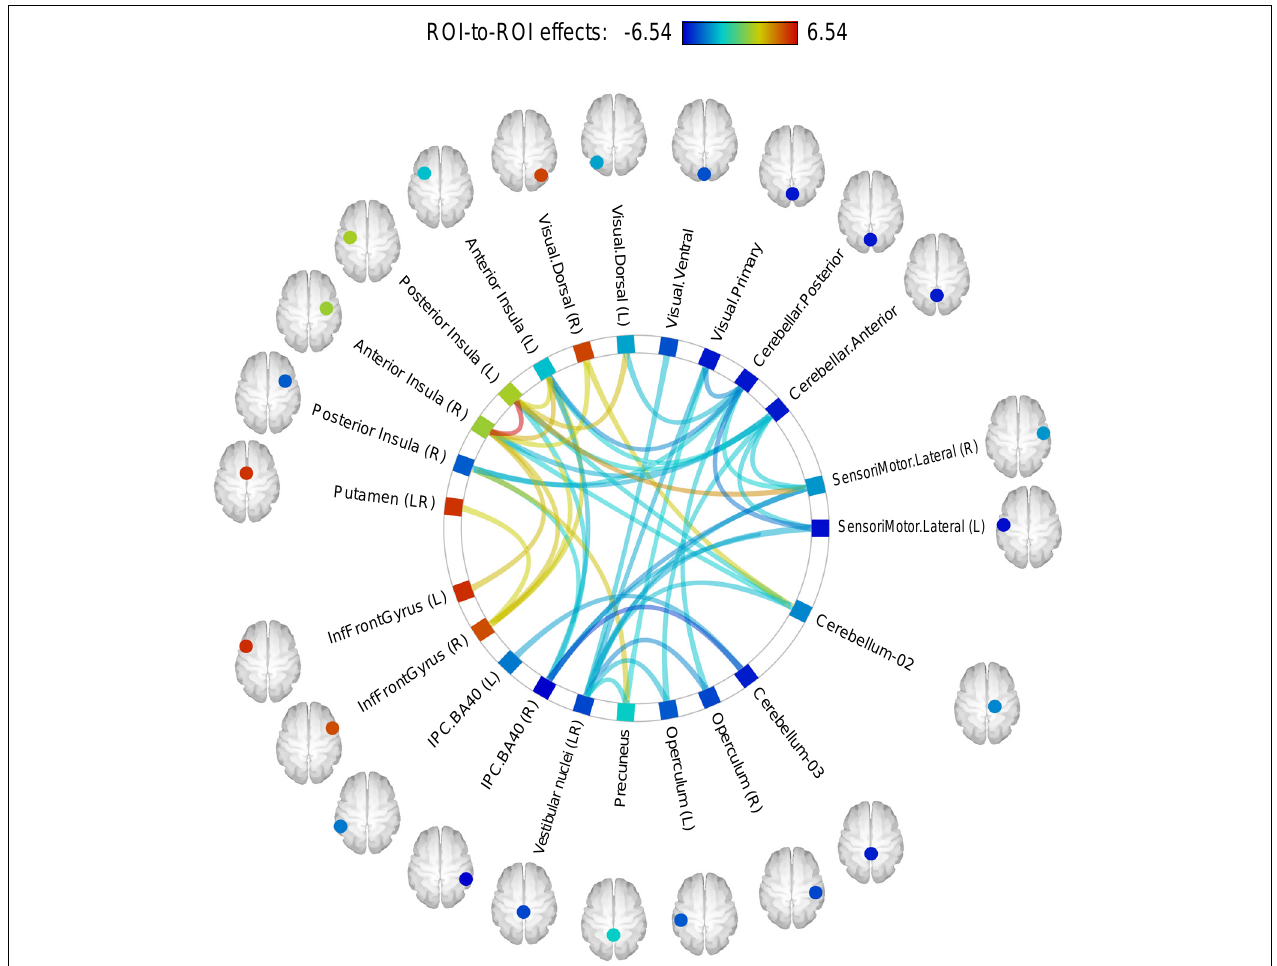
FIGURE 4 | A subnetwork identified by the NBS network-level ROI-to-ROI connectivity analysis and demonstrating changes in PPI connectivity values post-flight vs. pre-flight, cosmonauts vs. controls. Line color indicates the sign and magnitude of the effect for individual connections comprising the network. The network-defining threshold (connection-wise) was set to p < 0.05, and the network-level results were FWE-corrected for multiple comparisons (NBS by intensity, p < 0.05 at the network